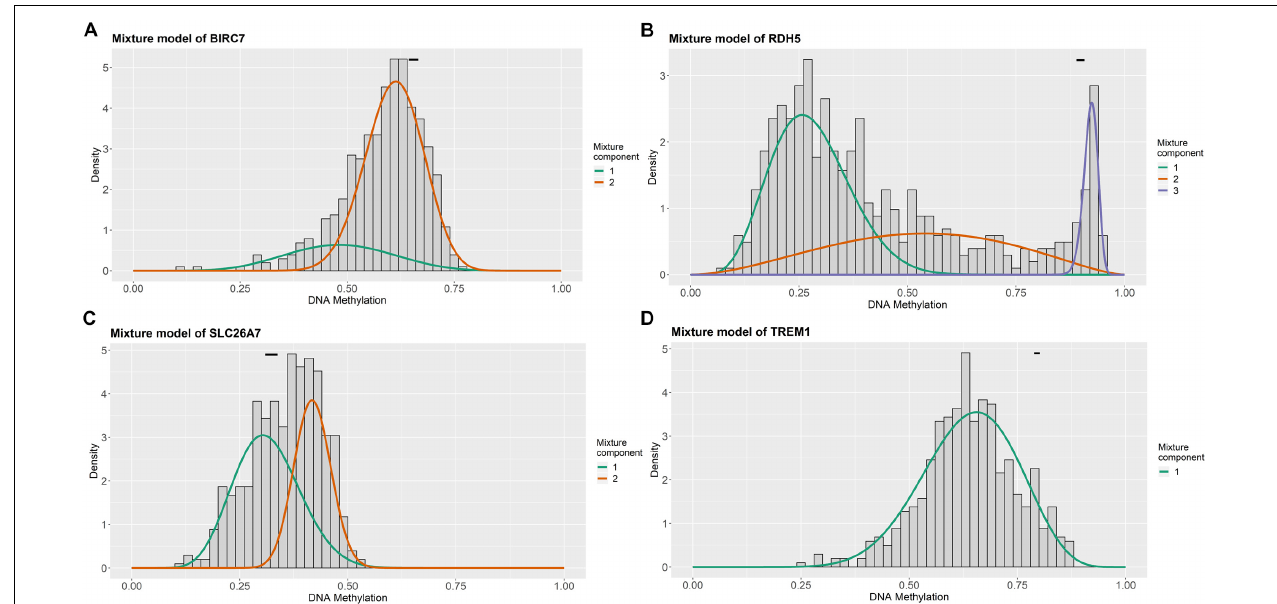
FIGURE 4 | Distribution map of the methylation degree of BIRC7 (A) , RDH5 (B) , SLC26A7 (C) , and TREM1 (D) in the risk model. X -axis represents the degree of methylation and Y -axis represents the number of methylated samples; The black horizontal line represents the methylation degree distribution in the normal samples.